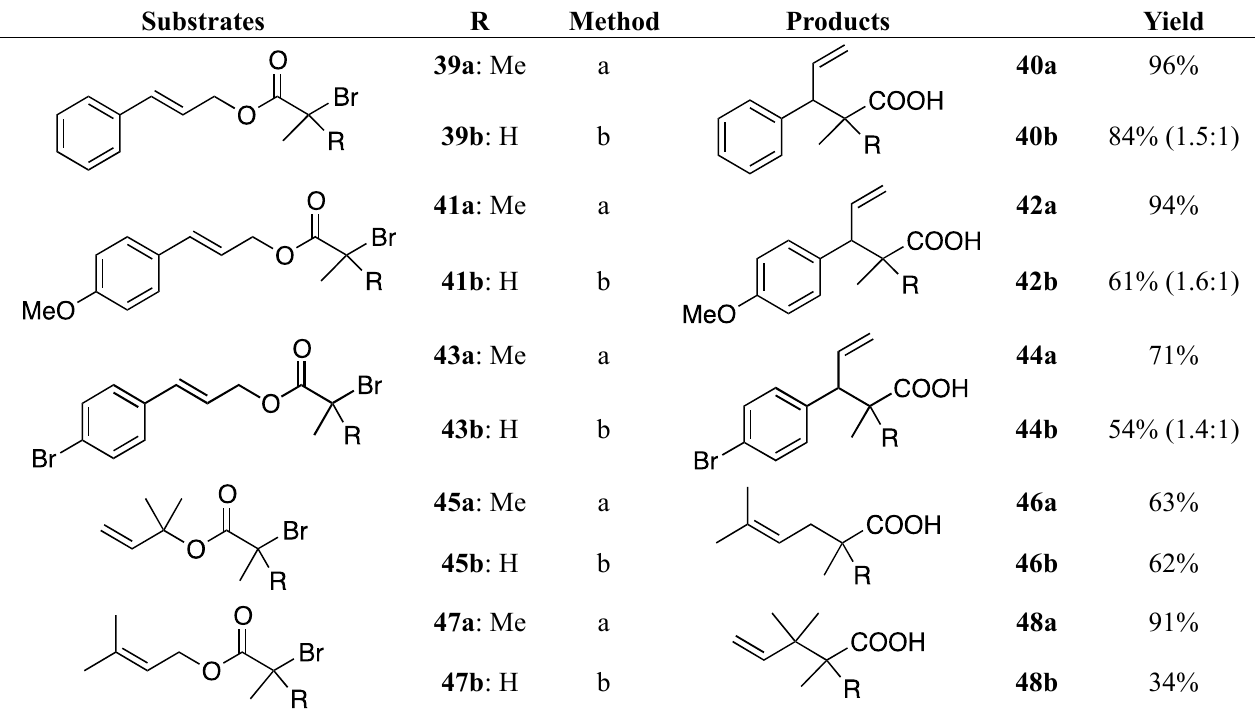
Table 2. Indium-mediated Reformatsky-Claisen Rearrangement of Various Substrates. Substrates R Method Products Yield 39a : Me 40a